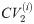
Single neuron statistics.a) Distribution P(ISI) at short values of ISIs for one representative cell in the network, by setting τα = 20 ms. Inset: same as main figure for the whole range of ISIs. b) Same as a) for τα = 2 ms. c-d) Corresponding Poissonian reconstruction of the P(ISI) for the same cases depicted in a) and b). e-f) Single neuron distribution of the CV2(i) for the same considered cases as in a) and b) calculated from the simulation (black solid lines with circles) and the Poissonian reconstruction (red dashed line with squares). The network parameters are ΔV = 5 mV and g = 8, remaining parameters as in Fig 1. Both the examined neurons have Is = −45.64 mV. For the Poissonian reconstruction the frequencies of the incoming uncorrelated spike trains are set to 〈ν〉N ≈ 7.4 Hz (〈ν〉N ≈ 8.3 Hz) for τα = 20ms (τα = 2ms), as measured from the corresponding network dynamics. The distributions are obtained by considering a sequence of 109 spikes in the original network, and 107 events for the Poissonian reconstruction.